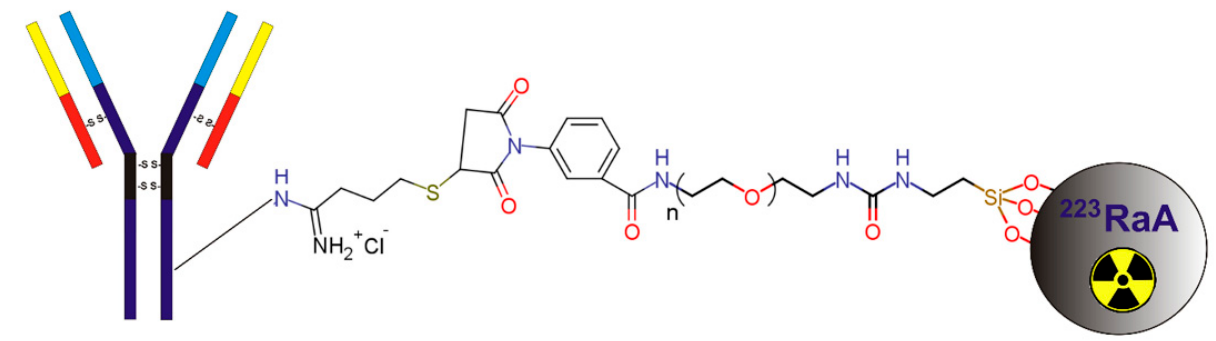
Figure 1. Scheme of 223 Ra-labeled nanozeolite particle functionalization with silane-PEG group and anti-PSMA D2B antibody.